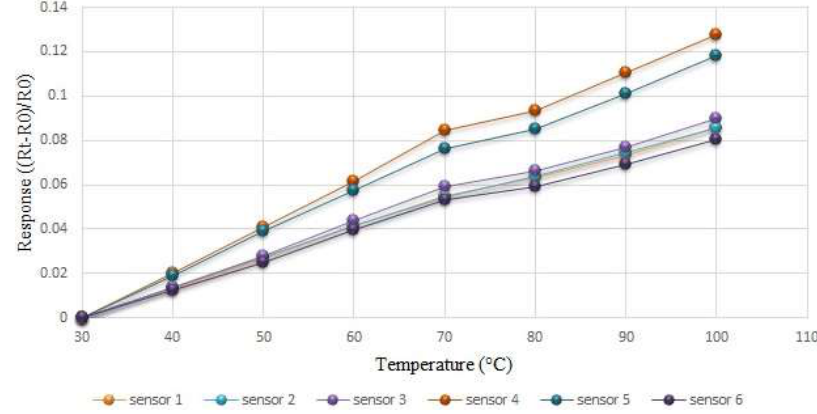
Figure 6. Average calibration curve of six temperature microsensors.